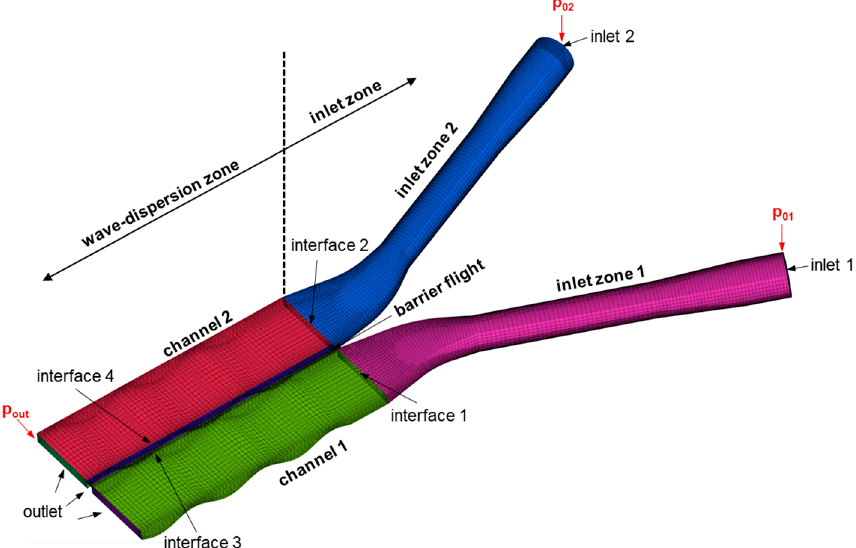
Figure 13. Schematic of the computational domain. Interfaces were used to merge the meshes of each subsection.